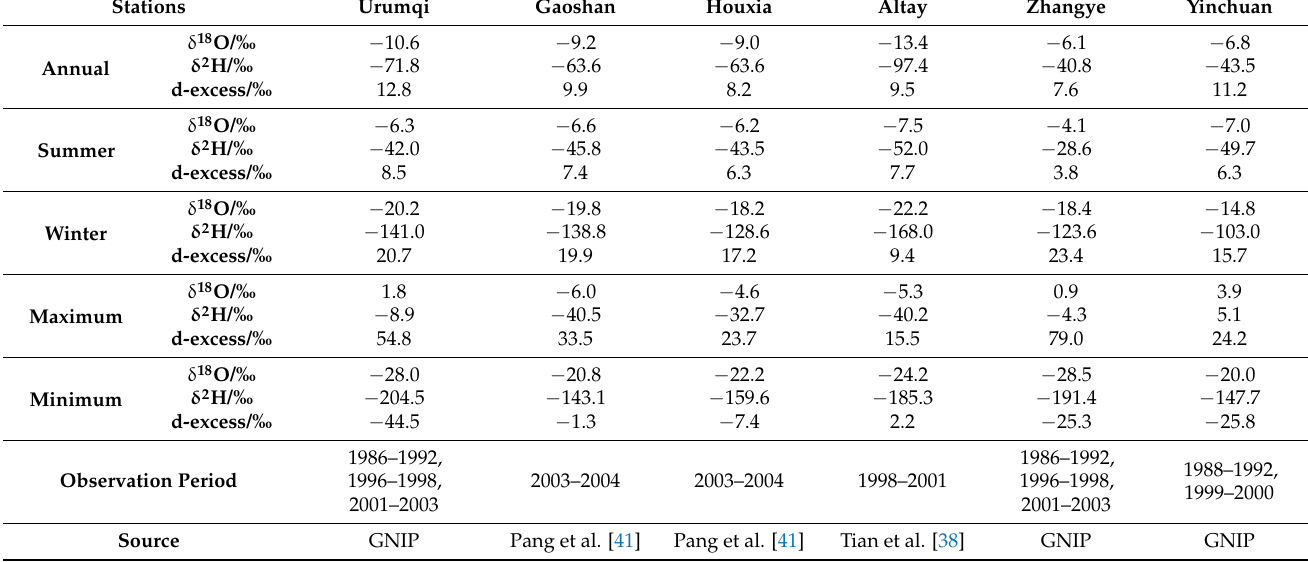
Table 1. Summary of precipitation isotope records at different stations in Northwest